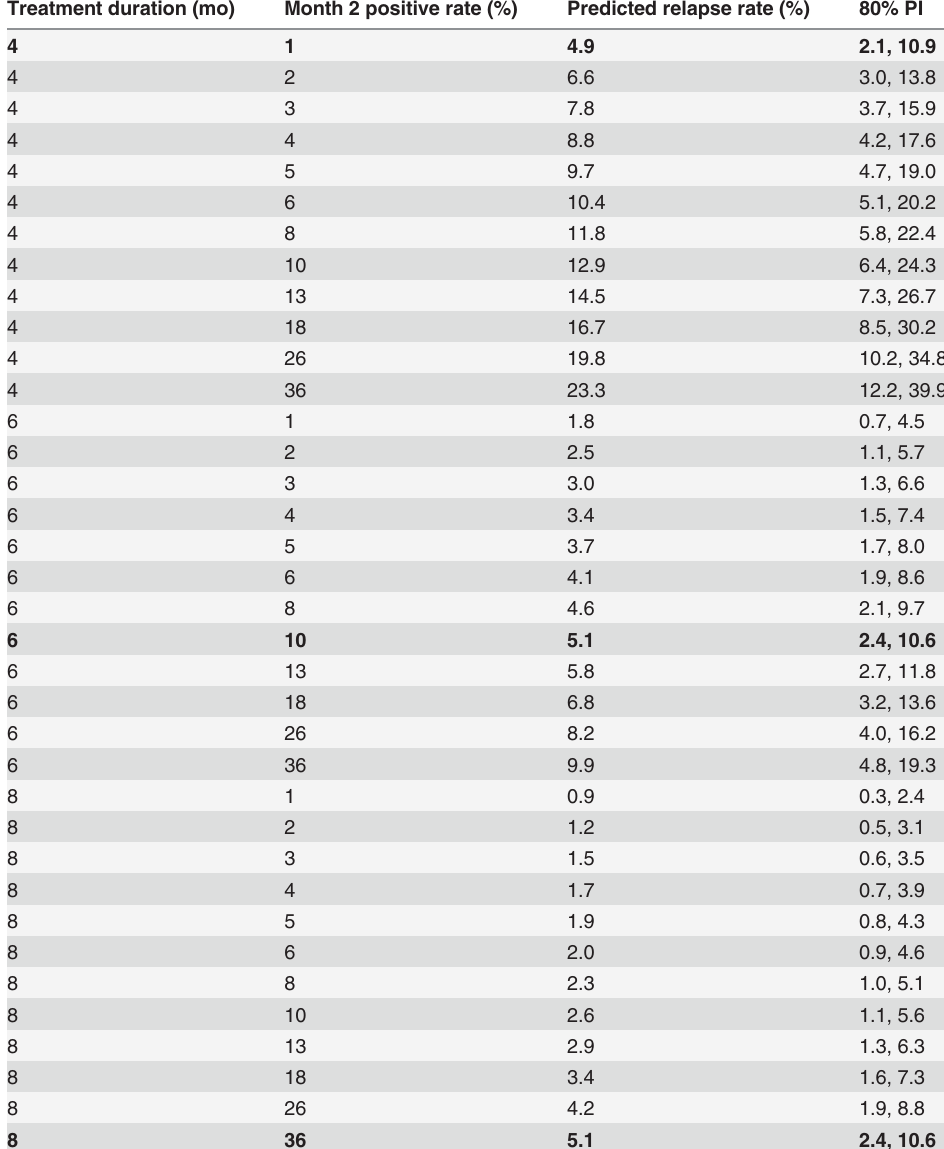
Table 4. Predicted relapse rates for hypothetical regimens of 4, 6, and 8 months duration. Treatment duration